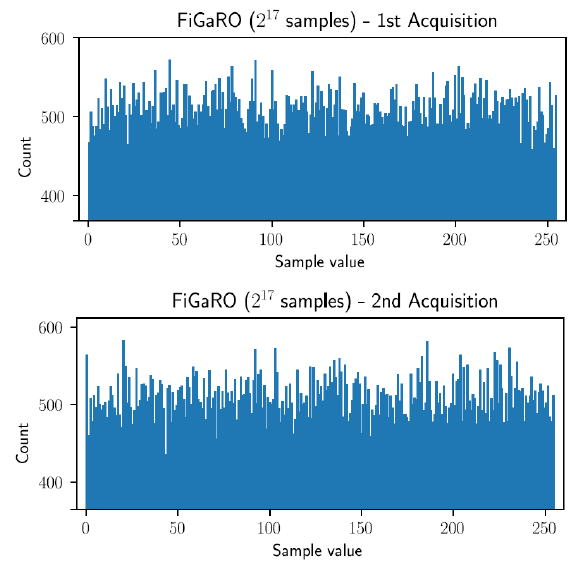
Figure 13. Histograms of the first run and of the second run of acquisitions for the FiGaRO